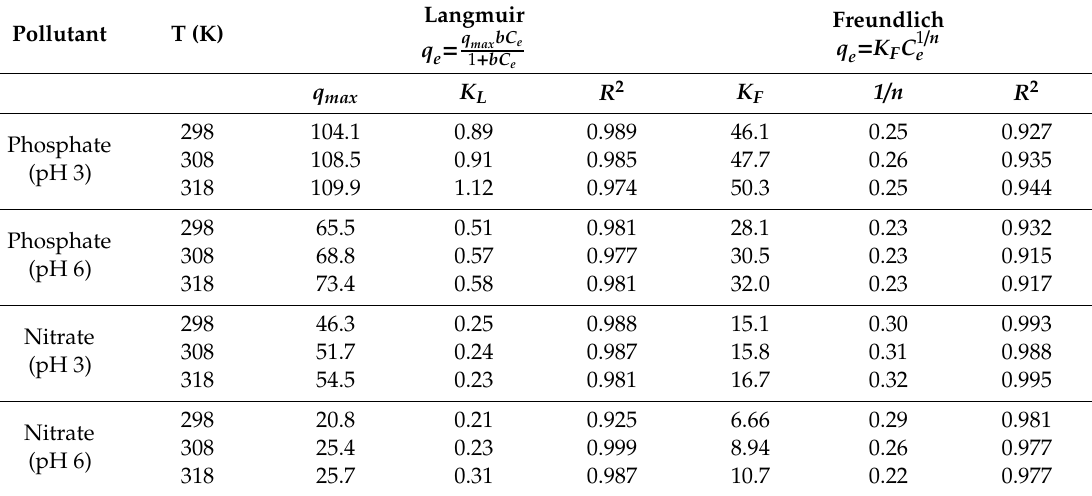
Figure 7. Plots of non-linear isotherm model results at different temperatures for phosphate adsorption at pH 3 ( a ) and at pH 6 ( b ) and for nitrate adsorption at pH 3 ( c ) and at pH 6 ( d ) onto SBAC 100 MgFe composite. Table 4. Parameters of non-linear Langmuir and Freundlich isotherm models for phosphate and nitrate removal by SBAC 100 MgFe composite at pH 3 and pH